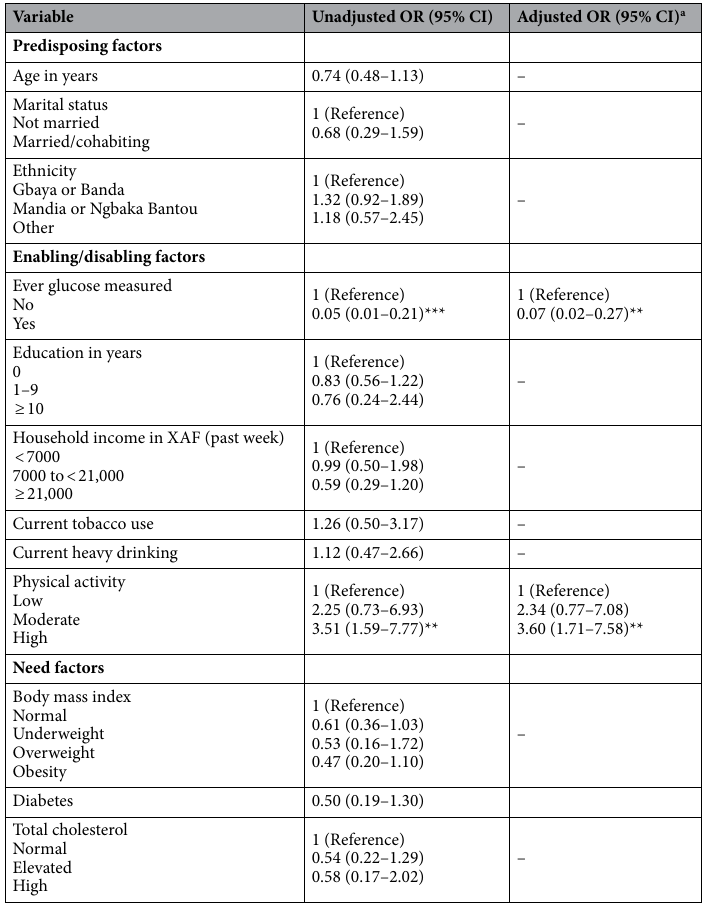
Table 3. Univariable and multivariable logistic regression reporting unadjusted and adjusted Odds Ratios (OR) for factors associated with undiagnosed hypertension among male adults with hypertension in Central African Republic, 2017. OR Odds Ratio; CI Confidence Intervals; * p < 0.05; ** p < 0.01; *** p < 0.001; a Adjusted for ever glucose measured, and physical